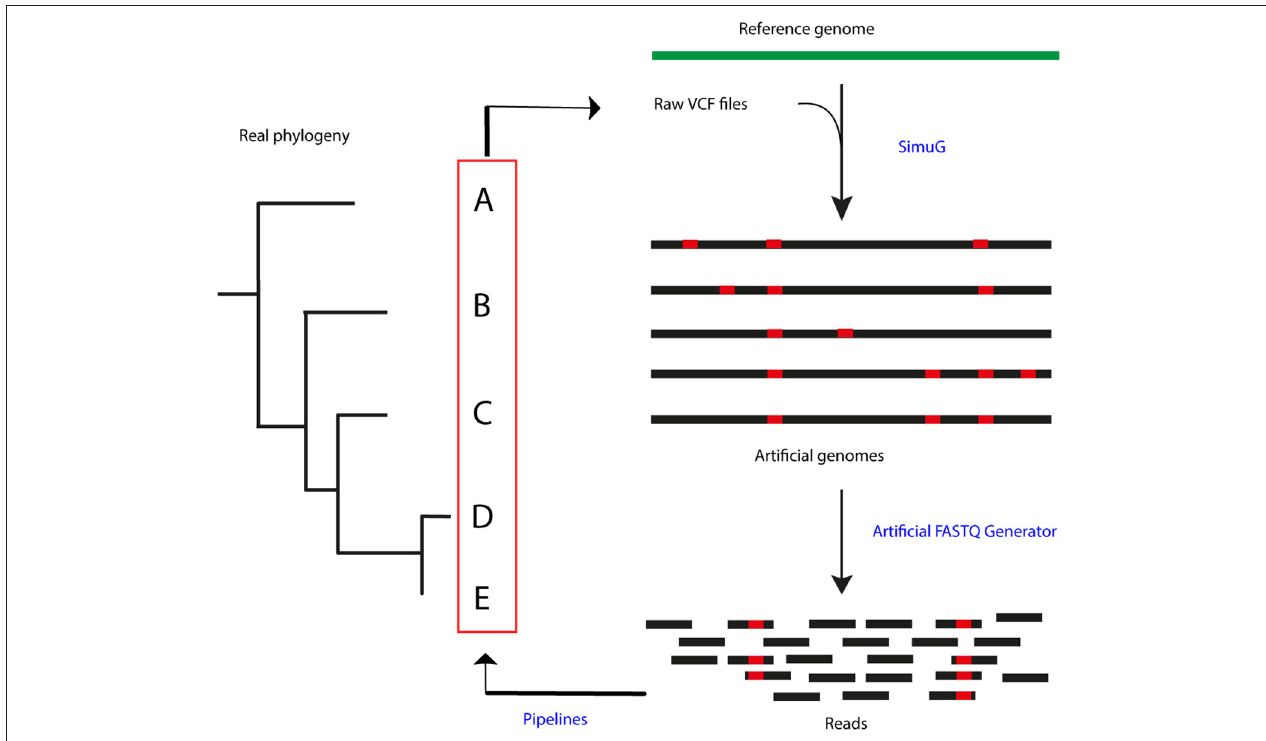
FIGURE 1 | Process summary. Raw VCF files obtained from a real-life phylogeny (22) were used to generate artificial genomes using SimuG and the M. bovis AF2122/97 reference genome. Artificial FASTQ Generator was then used to generate artificial reads and these were then input in the evaluated pipelines. Identified variants and output phylogenetic trees were compared between pipelines and the